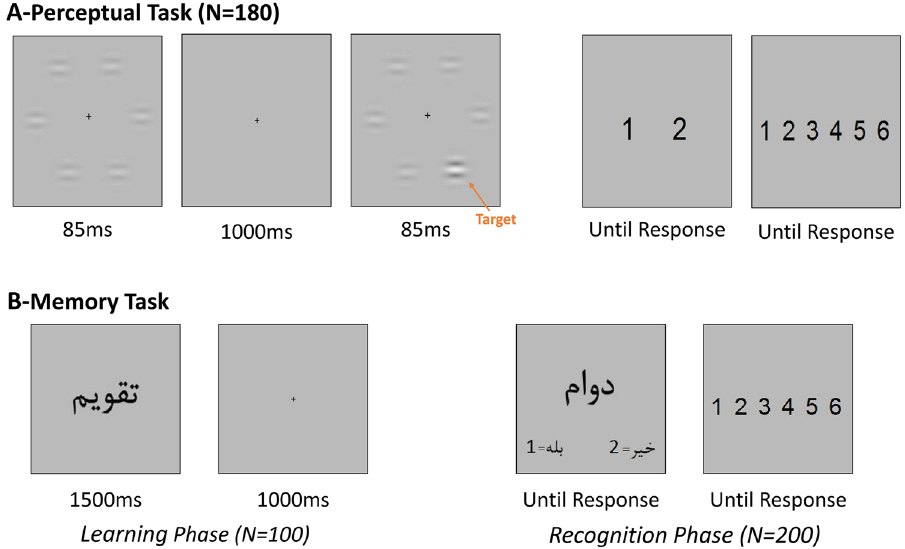
Figure 3. Outline of the perceptual ( A ) and memory ( B ) tasks. 2-AFC responses in both tasks are followed by rating confidence in a 1–6 scale. ( A ) One trial in the perceptual task (N = 180) consisted of two displays of 6 Gabor gratings each presented for 85 msec and separated by a 1000 msec ISI. Participant should indicate whether he observed the odd Gabor in the 1st or the 2nd interval. ( B ) The memory task included a learning and a recognition phase. During the learning phase (N = 100) each word is displayed for 1500 msec with 1000 msec interval between subsequent words. In the recognition phase (N = 200) a word was presented asking whether it was already seen or